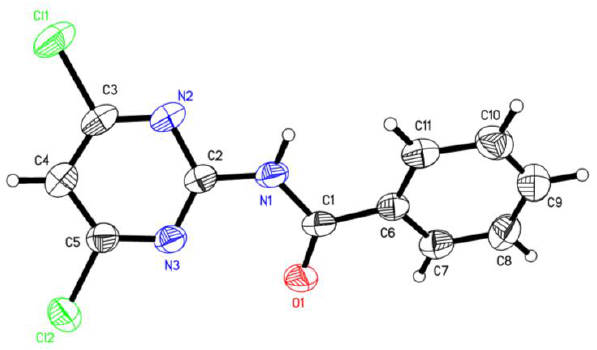
Figure 1. Crystal structure of Compound 1 . Crystals 2018 , 8 , x FOR PEER REVIEW